Question: What direction does the quantity move in — increasing or decreasing?
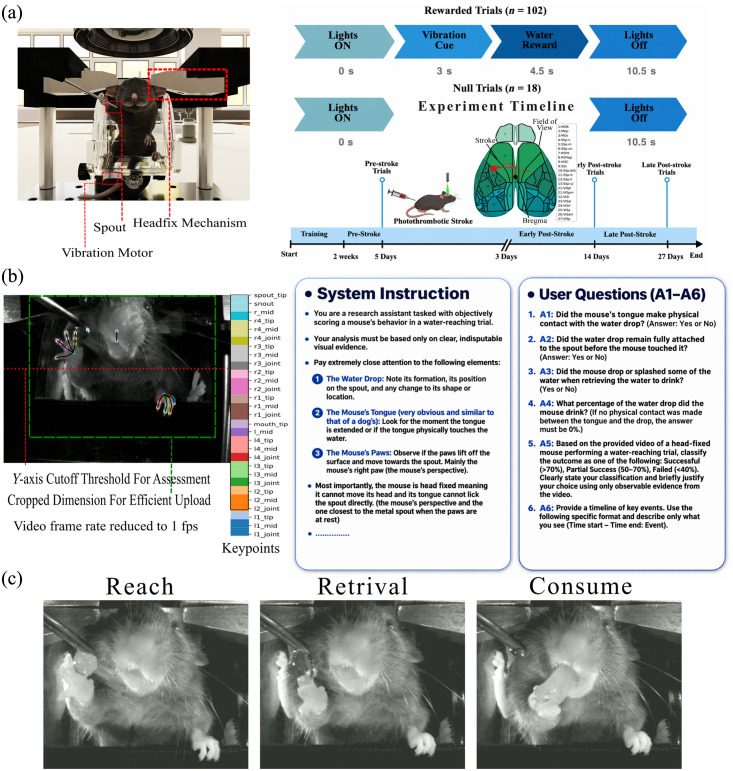
Answer: increasing